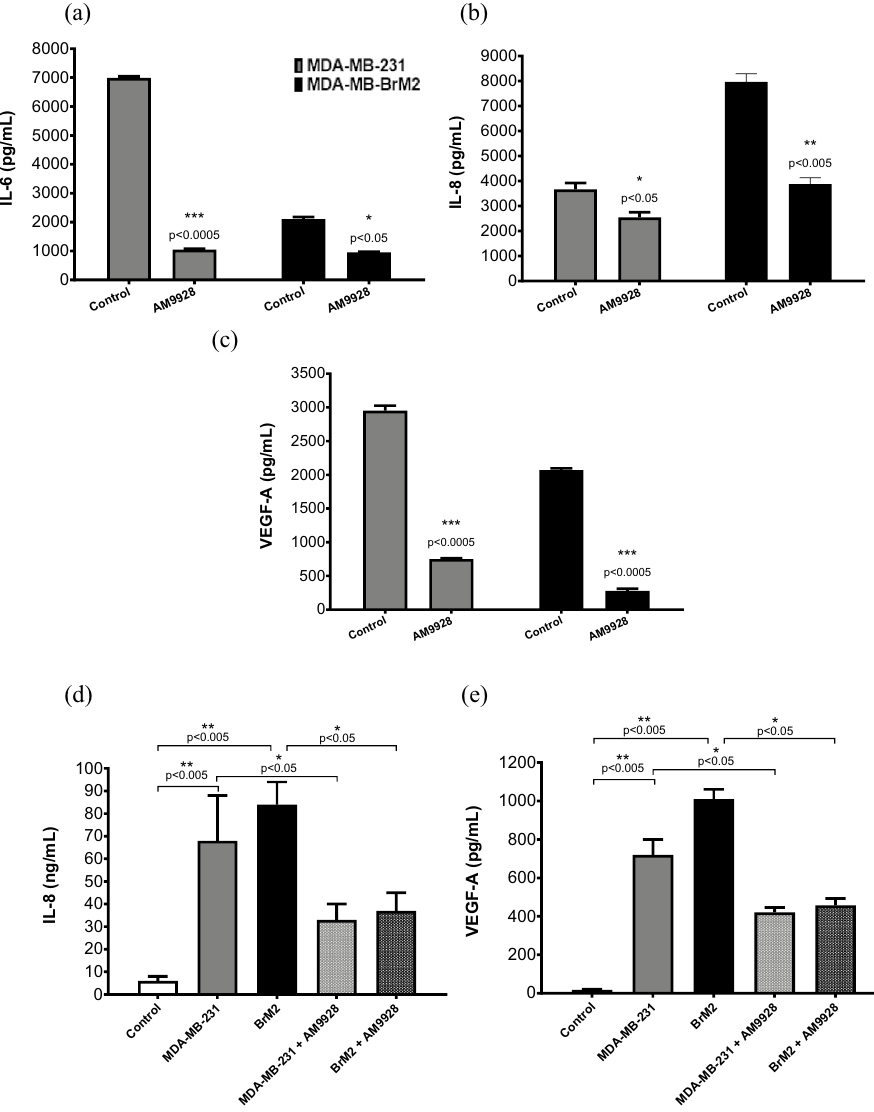
Figure 3. Expression levels of IL-6, IL-8, and VEGF-A in TNBC cells and in BMEC cells following exposure to exosomes derived from TNBC cells. ( a )–( c ): Expression levels of IL-6, IL-8, and VEGF-A in MDA-MB-231 and MDA-MB-BrM2 cells: cell supernatant samples were prepared from breast cancer cells treated with vehicle control or with AM9928, as indicated and the levels of the human cytokines/chemokines were measured using specific ELISA assays for human IL-6, IL-8, and VEGF-A (R&D Systems ® ELISAs). Data shown are representative of at least three independent assays performed on triplicate wells. The error bars indicate standard deviations. * p < 0.05 as compared to vehicle control, ** p < 0.005 as compared to vehicle control and *** p < 0.0005 as compared to vehicle control. ( d )–( e ): Expression levels of IL-8 and VEGF-A in HBMECs: Exosomes were isolated from either MDA-MB-231 or MDA-MB-231BrM2 cells treated with vehicle control or with AM9928 for 24 h as indicated. Exosomes were then isolated and were incubated with human BMECs in 3D-cocultures for 6 h. Supernatants from HBMECs were collected after 24 h and analyzed for IL-8 and VEGF-A using ELISA assays. Data shown are representative of at least three independent assays performed on triplicate wells. The error bars indicate standard deviations. * p < 0.05 in untreated exosomes derived from MDA-MB-231 cells or MDA-MB-231-BrM2 cells as compared to TNBC cells treated with AM9928 and ** p < 0.005 as compared to HBMECs control, as indicated in the